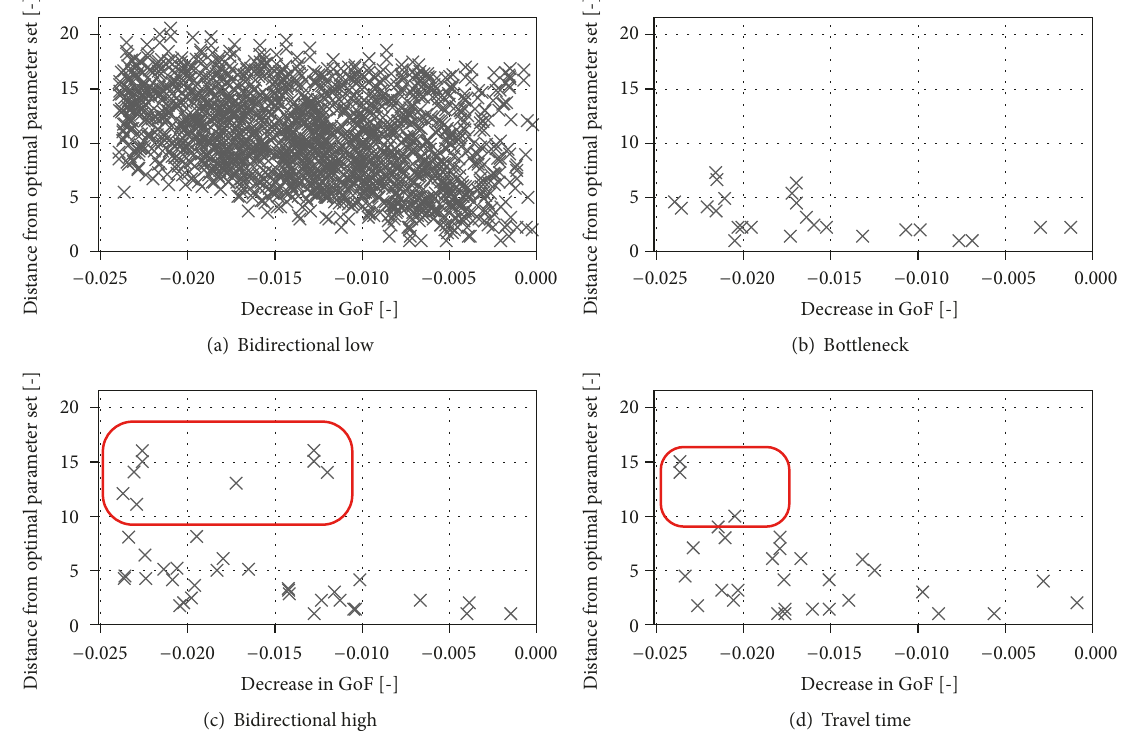
Figure 6: The deviation from optimal GoF versus the distance to the optimal parameter